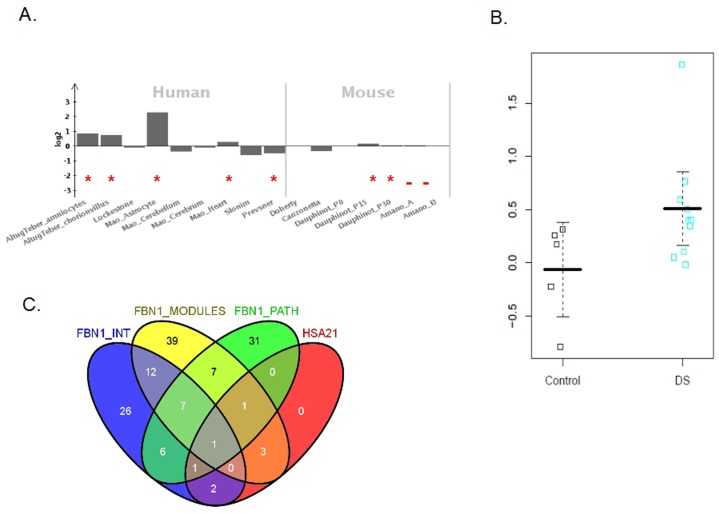
The role of FBN1 and related genes in Down Syndrome.(A) The Meta-analysis results for FBN1. The major part of the studies with proved presence of expression are upregulated (red cruises P-value of presence <0.05, red dots P-value of presence <0.1). (B) Boxplot of deregulation of FBN1 in DS heart. (C) Total number of significant in at least one study related to FBN1 neighbours (FBN1_INT), Functional Modules (FBN1_MODULES), related Pathways (FBN1_PATH) and genes on HSA21.